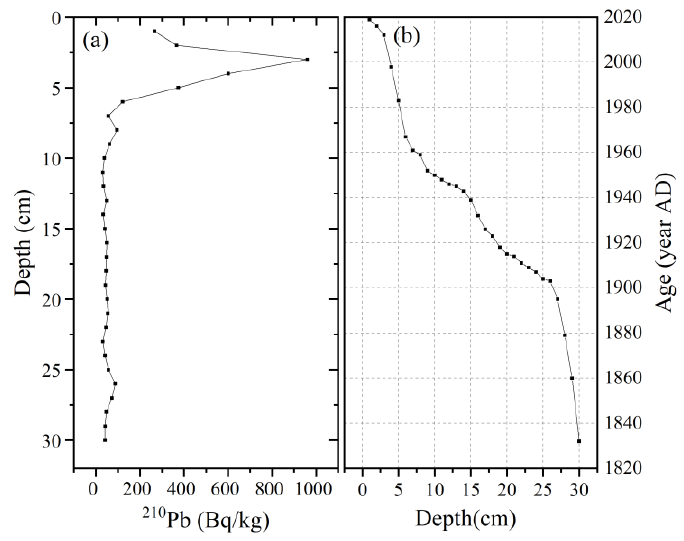
Figure 2. Variation of 210 Pb ( a ) and the CRS calculated age ( b ) at the HH peatlands.